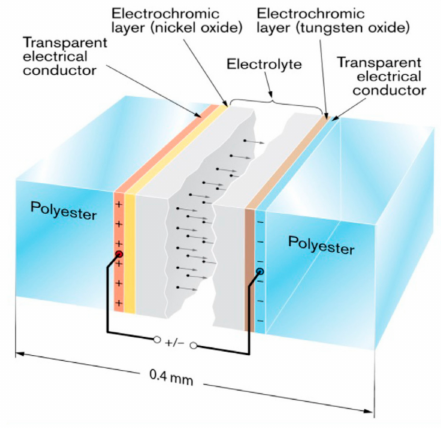
Figure 1. Web-coated electrochromic (EC) devices in the form of large flexible sheets, as a foil for glass lamination. Reproduced from [31], Elsevier: